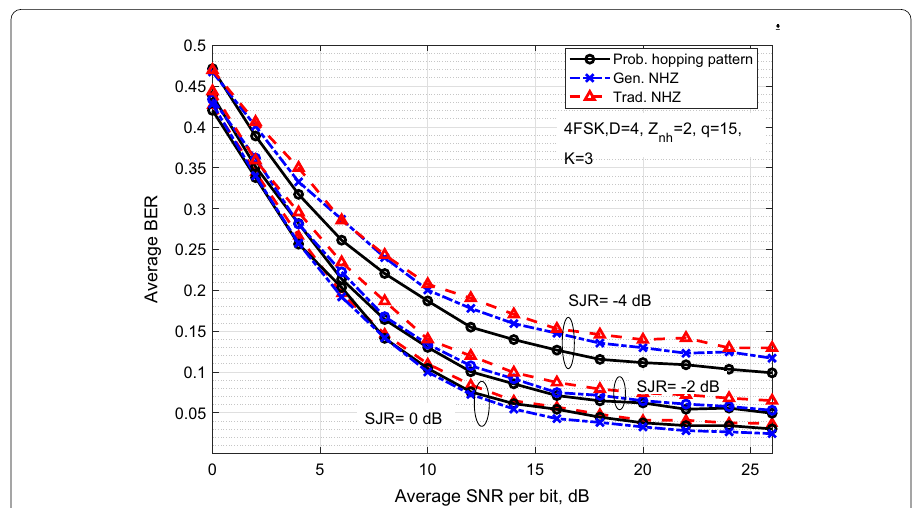
Fig. 6 The BERs of the channel-hopping-based wireless multi-node IoT networks for various SJR s with multiple legitimate users ( K = 3